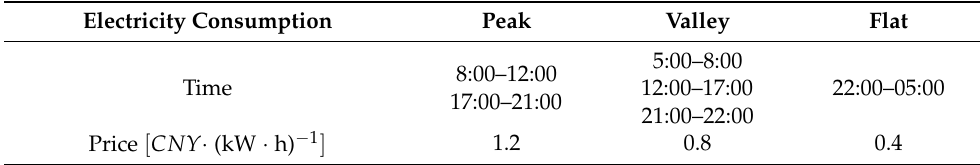
Table 1. Peak–valley–flat time and price of electricity load in SY city.